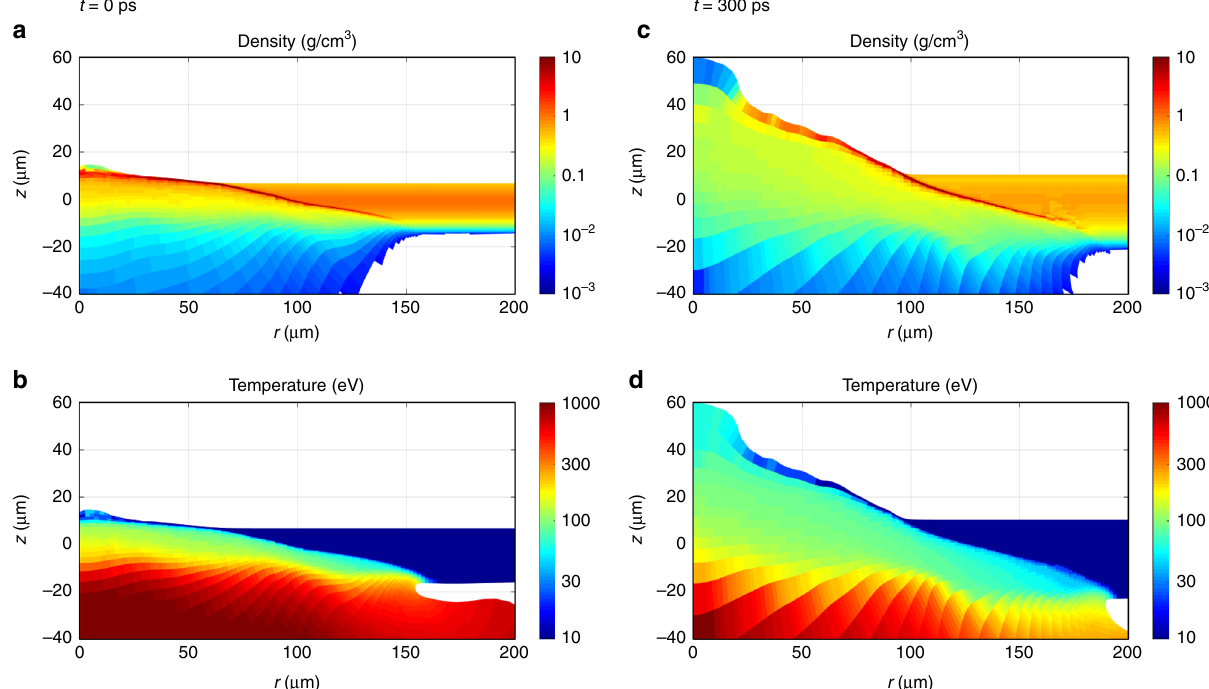
Fig. 4 Plasma pro fi les from the hydrodynamic simulation. 2D distributions ( r ; z ) of the plasma mass density ( a , c ) and temperature ( b , d ) on logarithmic scale obtained from the hydrodynamic simulation at the time of the laser pulse maximum ( t ¼ 0) (a, b ) and at the end of the laser pulse, t ¼ 300 ps ( c , d)